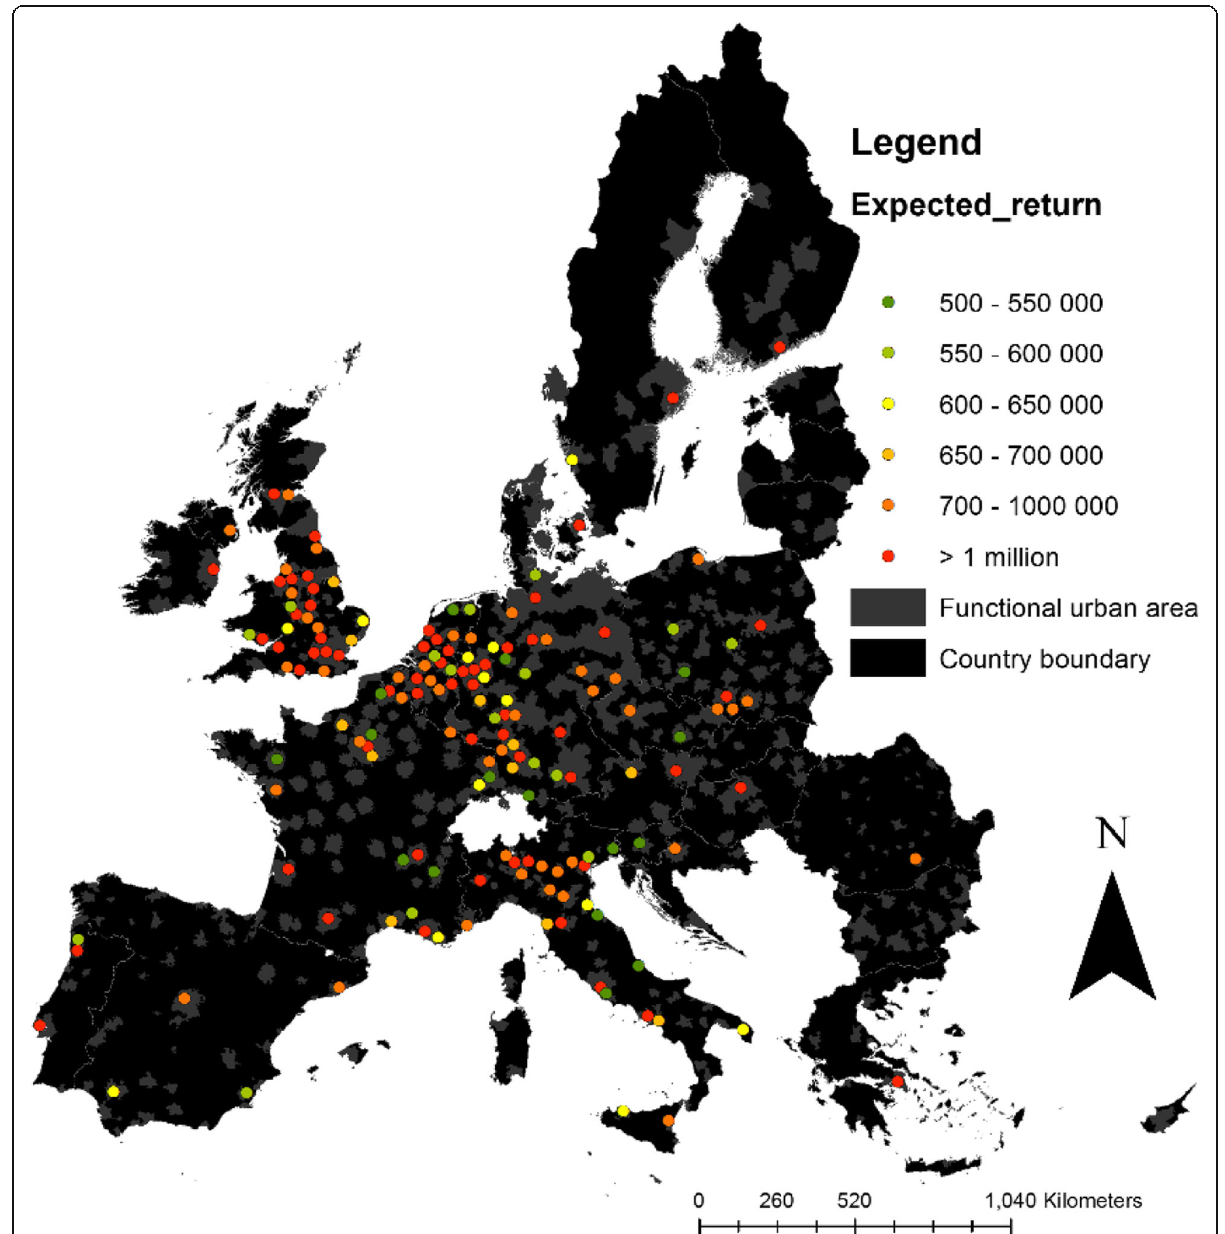
Fig. 16 Spatial distribution of hives for Scenario 4 under 6 different economic viability